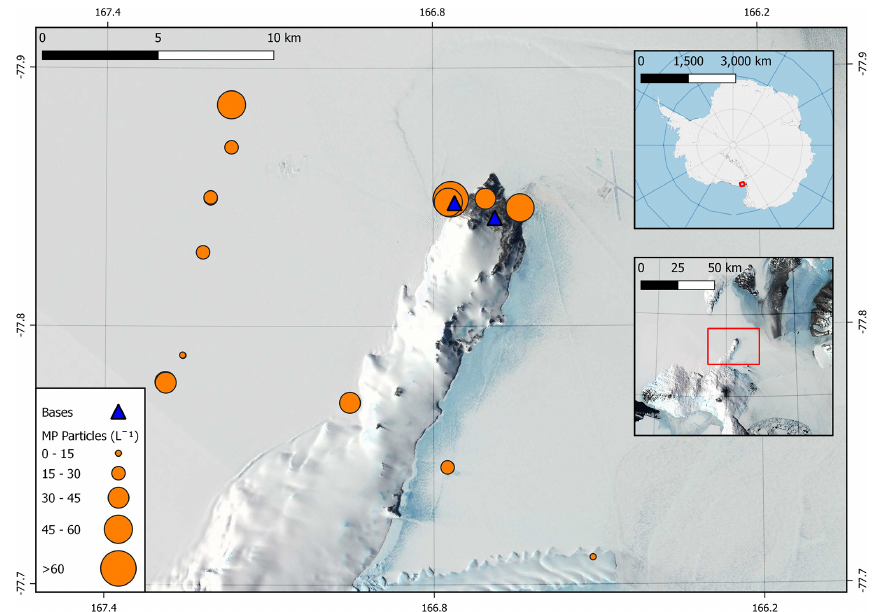
Figure 3. Concentrations of microplastics (MP; in particlesL − 1 ) at each sampling site in the Ross Island region. Insets provide an overview of the location of sampling sites in Antarctica. Map data sourced from Matsuoka et al.